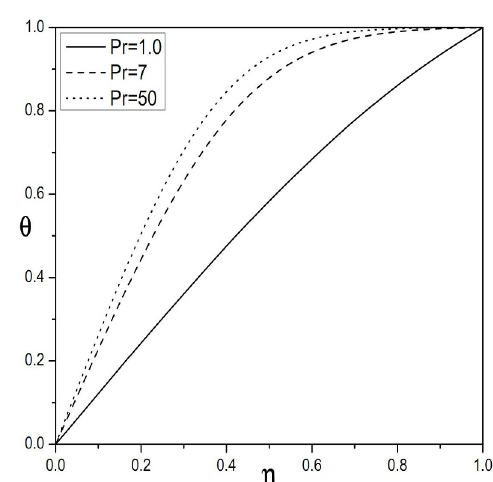
The effect of Prandtl number Pr on the heat transfer coefficients for fixed values of Re = 0 . 2 and S = 0 . 01 is also presented in Table 1. It can be seen that θ 0 increases where as θ (1) decreases with an increase in the Prandtl number.